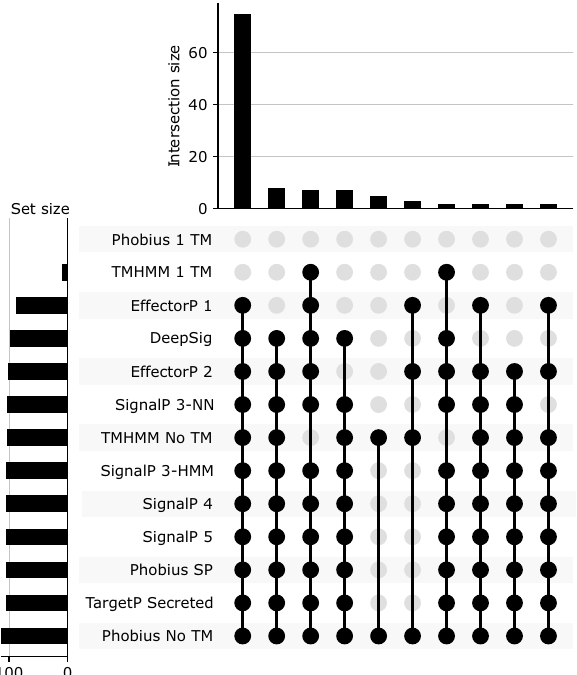
Figure 1. UpSet plot showing predictions of signal peptides, transmembrane domains, and effector-like properties for all known effectors in the training dataset (N = 125). Rows indicate sets of proteins predicted to have a property related to effector prediction (e.g. a signal peptide), with the horizontal bar chart indicating set size. Columns indicate where the horizontal sets intersect with each other, where the vertical bar-chart indicates the number of proteins in that intersection. For clarity, intersections with only 1 member have been excluded, the full plot is presented in Supplementary Data